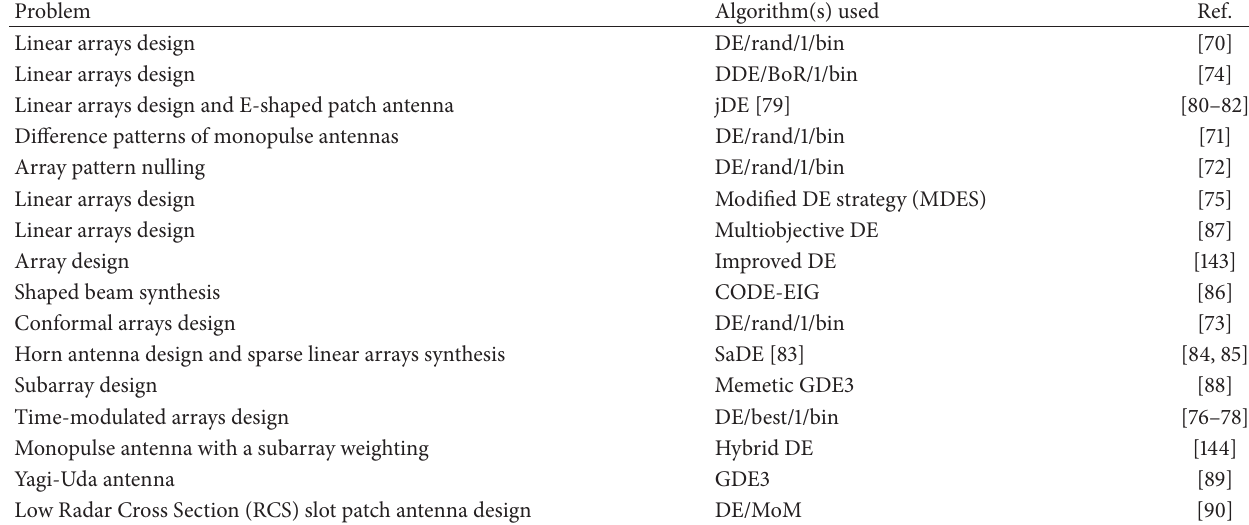
Table 3: Selected journal papers that use DE for antenna